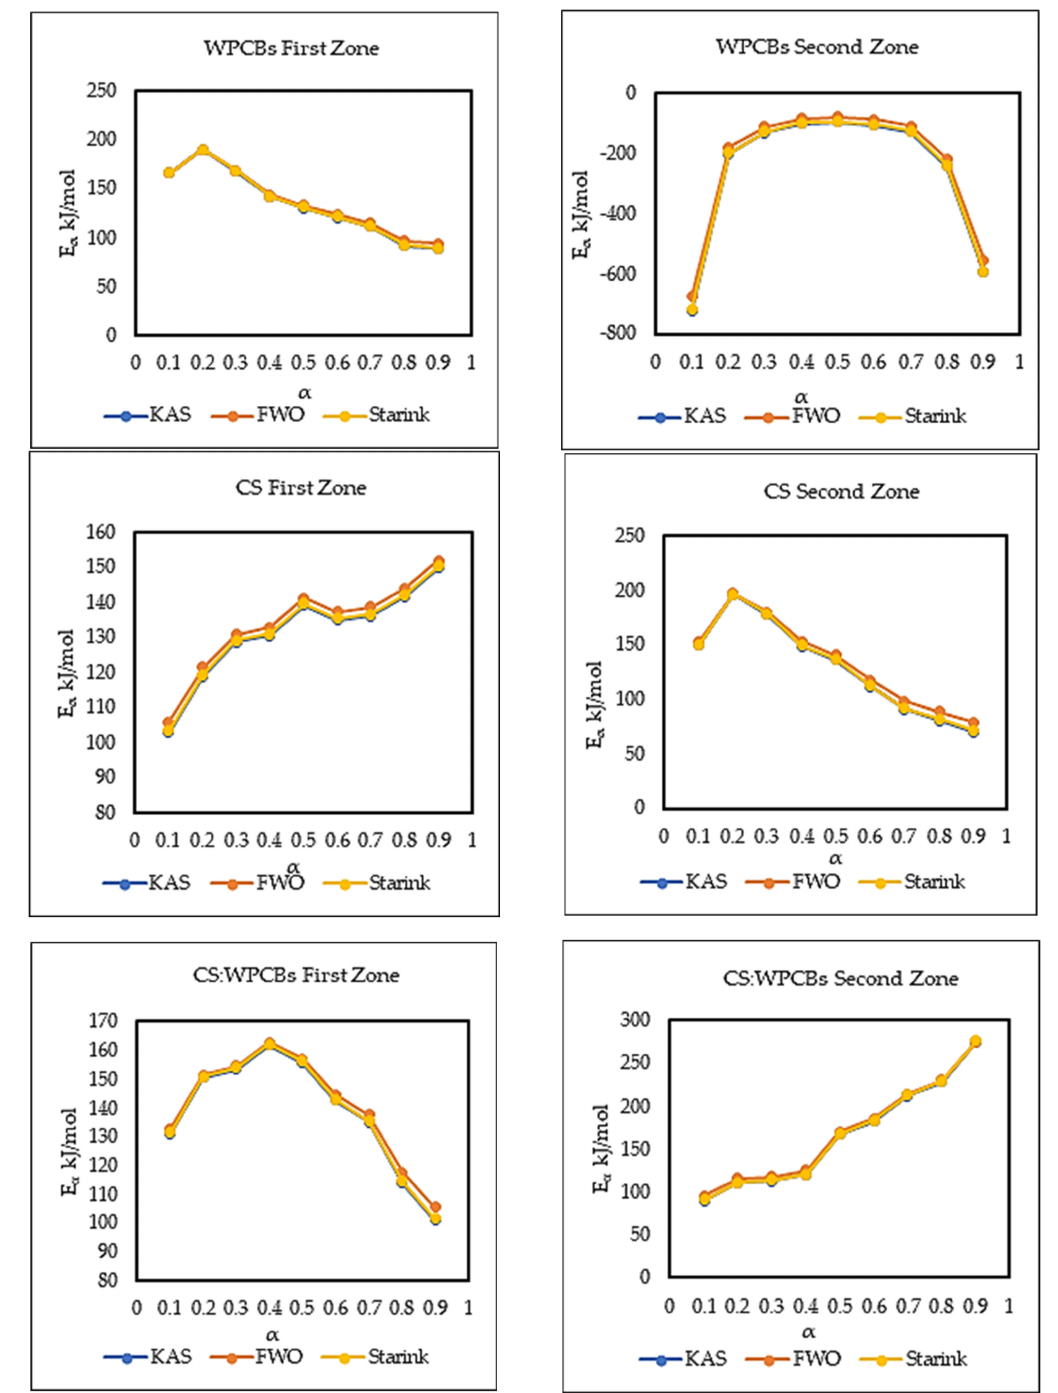
Figure 4. Dependence of activation energy on the conversion ( α ) for WPCBs, CS, and CS:WPCBs for first and second zone, according to FWO